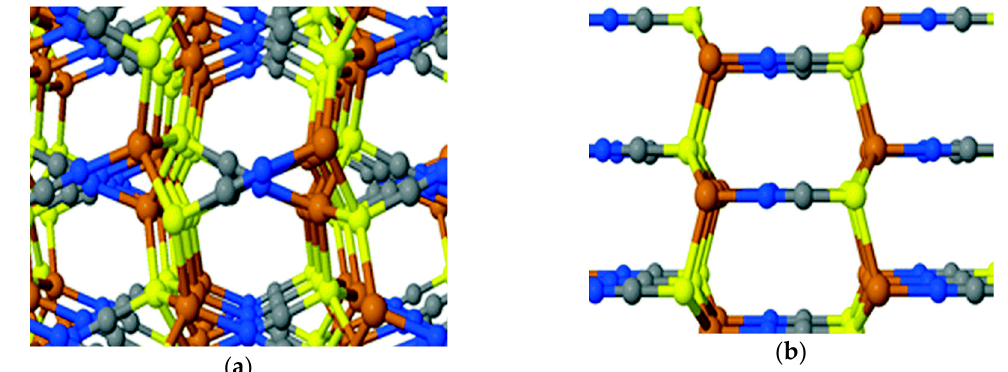
Figure 3. Bulk three-dimensional phases of CuSCN: ( a ) α -phase (orthorhombic); ( b ) β -phase (hexagonal) where brown sphere = Cu; yellow sphere = S; gray sphere = C; and blue sphere = N. Reproduced with permission from Reference [38]. Wiley 2017.